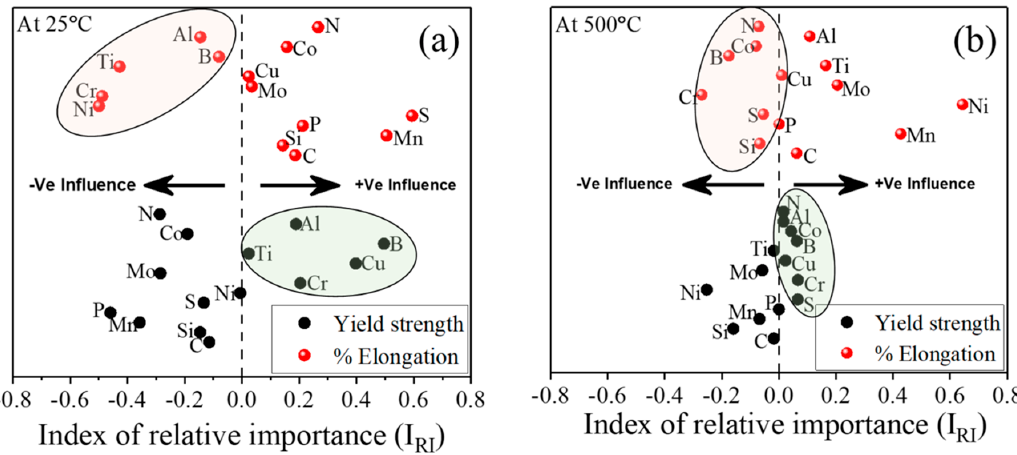
Figure 6. Significant importance of various alloying elements on YS and % El of TAA steel at ( a ) 25 °C and ( b ) 500 °C.